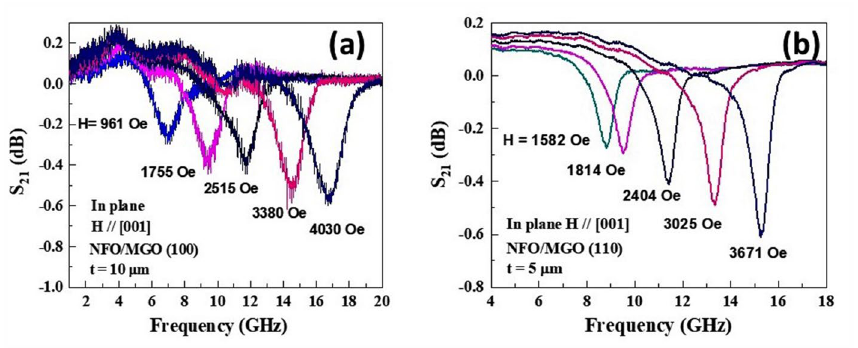
Figure 7. ( a ) S 21 vs f profiles as a function of H applied parallel to [001] direction for 10 µ m thick NFO on (100) MGO. ( b ) Profiles as in ( a ) for H//[001] for 5 µ m thick film of NFO on (110) MGO.